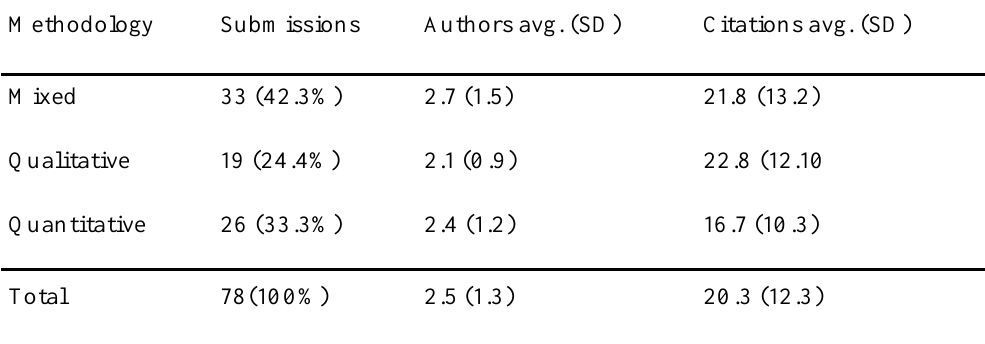
Phase 2 Distribution of Research Methodologies Methodology